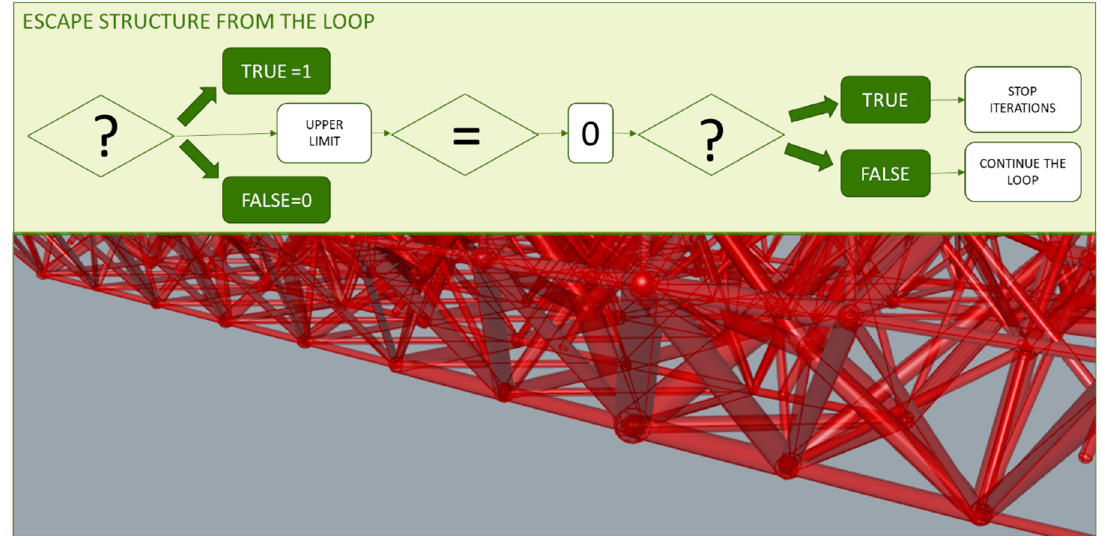
Figure 13. Programming structure of the escape sequence of the previous loop.